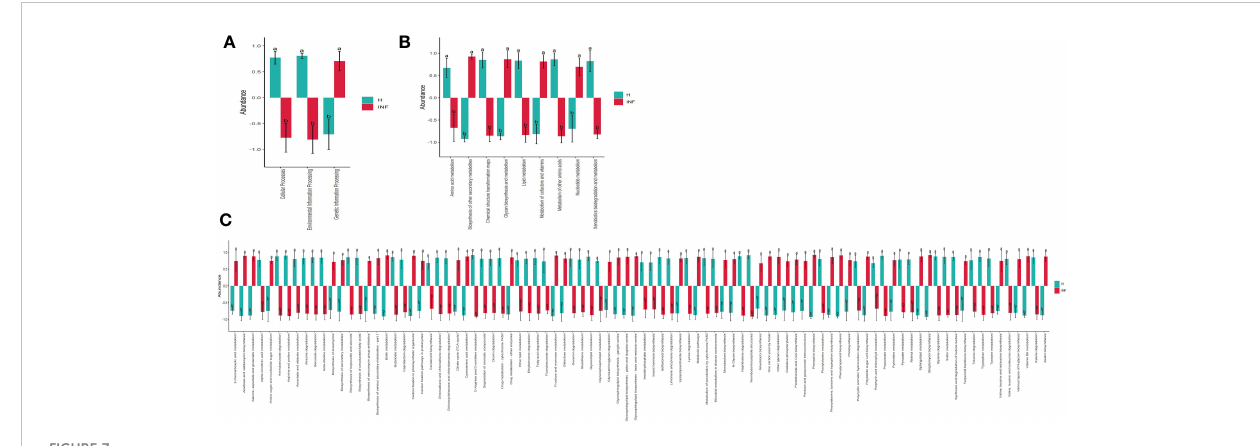
FIGURE 7 Cryptosporidium infection potentially affected the microbiota function of yaks. (A) KEGG L1 ( p <0.05), (B) KEGG L2 ( p <0.05), (C) KEGG L3 ( p <0.05). "a, b" are showing signi fi cance relation.